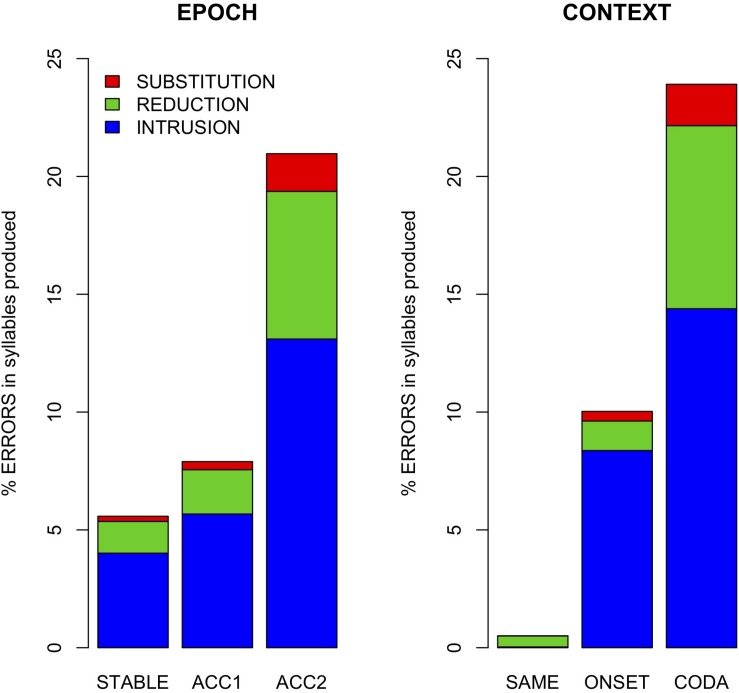
Error rates by epoch and context across all speakers.